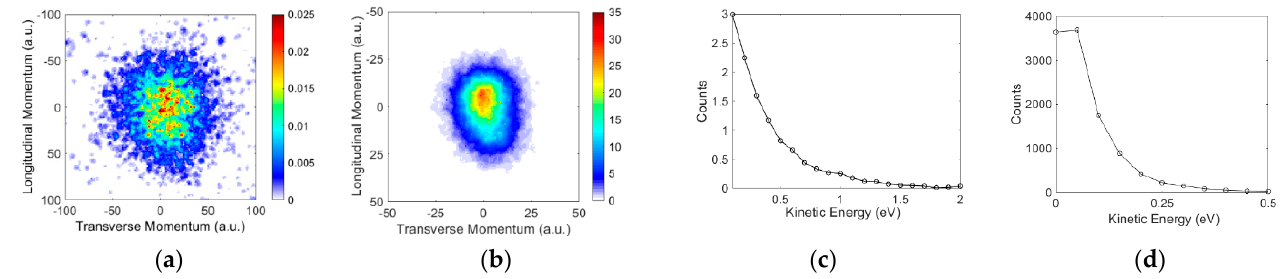
Figure 6. Momentum images obtained for the CN − ions from ( a ) aniline at 9.6 eV and ( b ) benzylamine at 5.5 eV. The incoming electron beam direction is from top to bottom; ( c , d ) are the respective kinetic energy distributions.